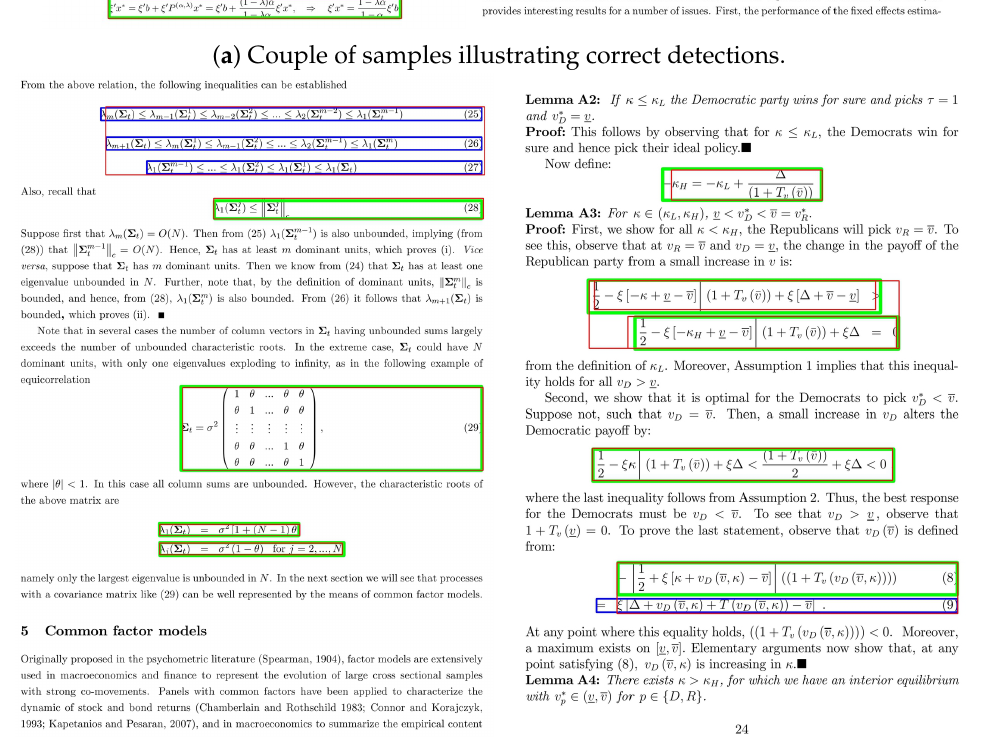
Figure 12. Instances of correct and partial detection of isolated formulas on the Marmot dataset. The green color represents the correct detections, whereas the partial and missed detections are highlighted with red and blue colors, respectively. ( a ) depicts a couple of samples of correct detection in which an IoU score between ground truth and predicted region is greater than or equal to 0.5, whereas ( b ) illustrates a few cases of partial and missed